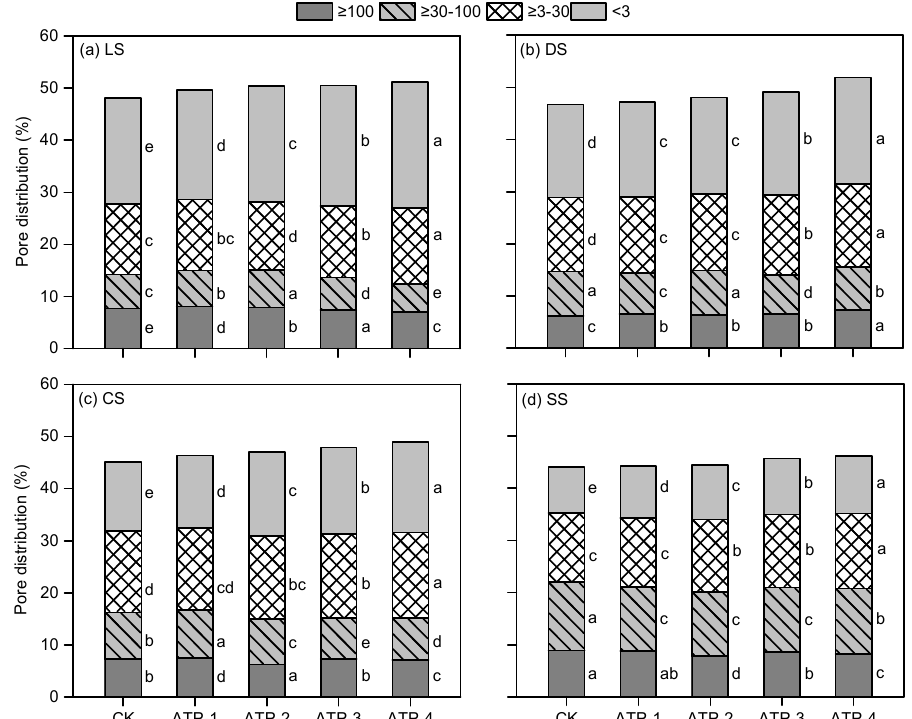
Figure 3. Pore size distribution for lou soil (LS), dark loessial soil (DS), cultivated loess soil (CS), and sandy soil (SS). Different lowercase letters indicate significant differences in the parameters for different ATP amounts applied in the same pore size.